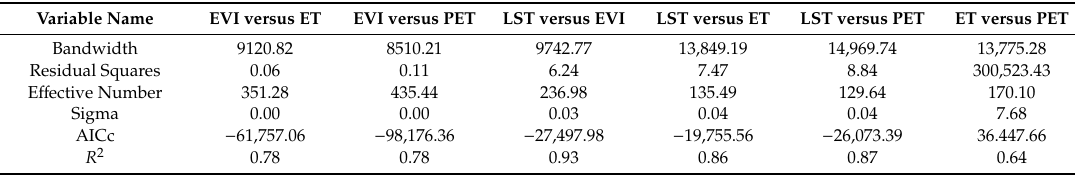
Table 4. Summary of results when applying GWR